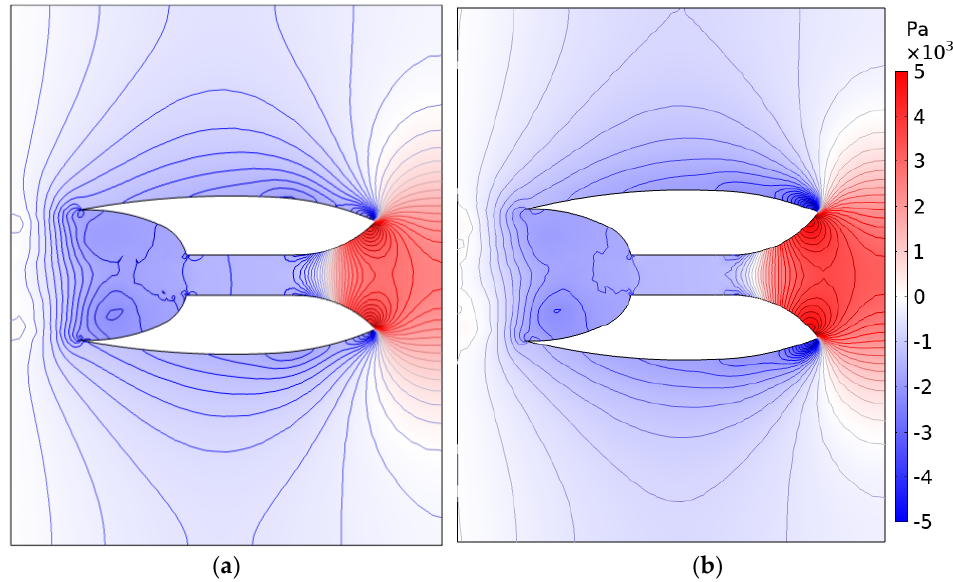
Figure 18. Distribution of relative pressure to the outside reference 1 atm , in the free-flow condition for models D3 ( a ), and D4 ( b ).